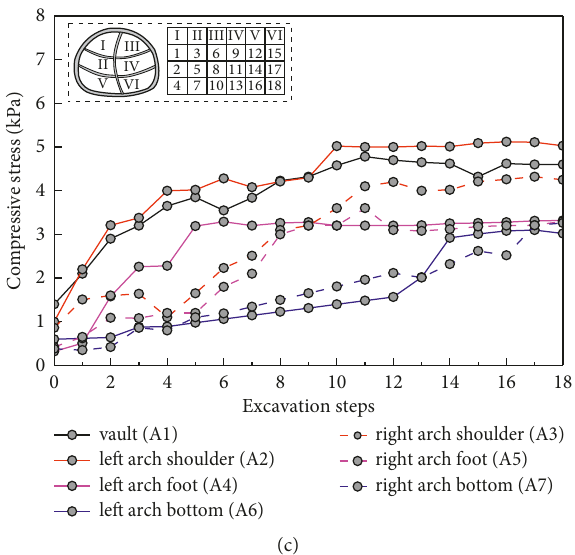
Figure 6: Stress variation of the surrounding rock under different excavation methods without pre-reinforcement. (a) Two-step excavation method. (b) CRD-4 excavation method. (c) CRD-6 excavation